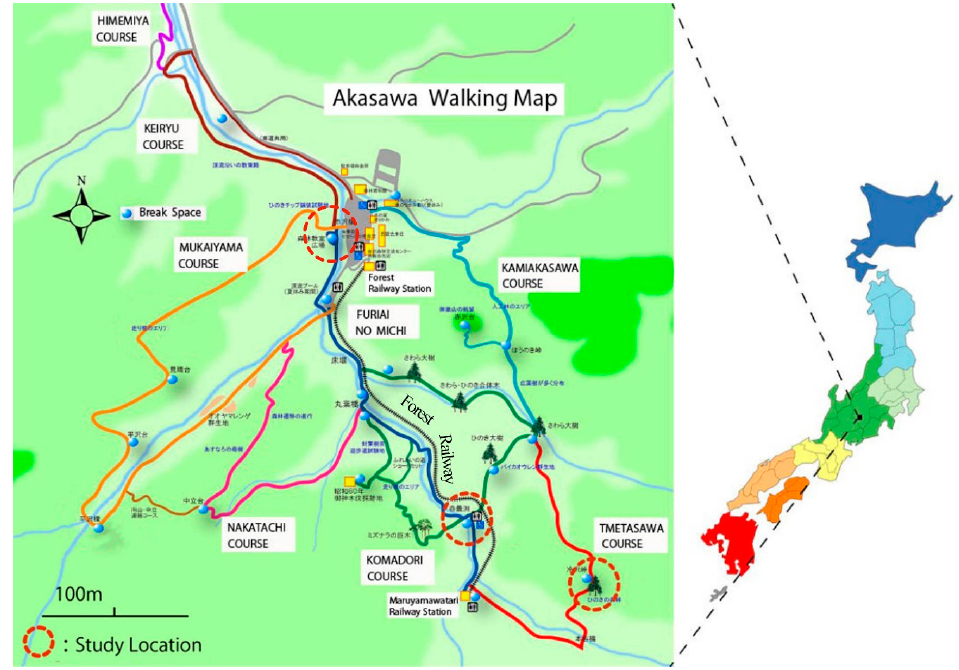
Figure 1. Akasawa National Recreational Forest.